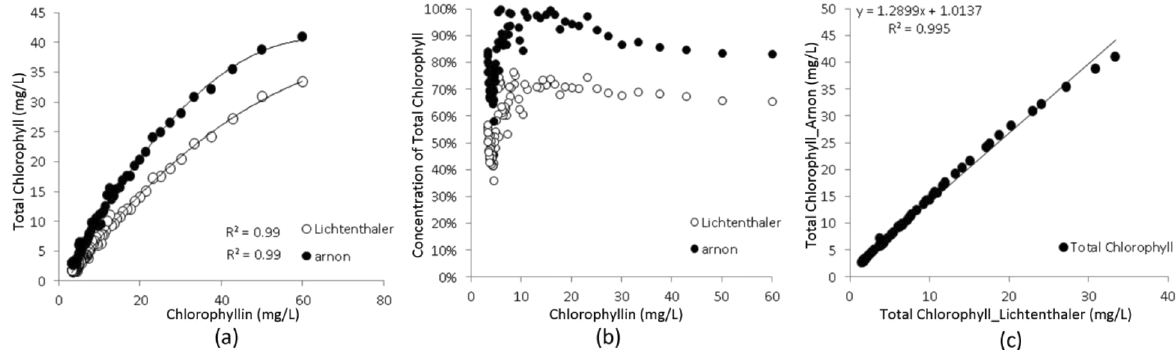
Fig. 4. (a) Correlation between total chlorophyll and chlorophyllin concentrations in mg/L; (b) relationship between total chlorophyll concentration (assay in percent %) and chlorophyllin concentration (mg/L) with different methods of chlorophyll determination; (c) correlation between Lichtenthaler and Arnon method in determining total